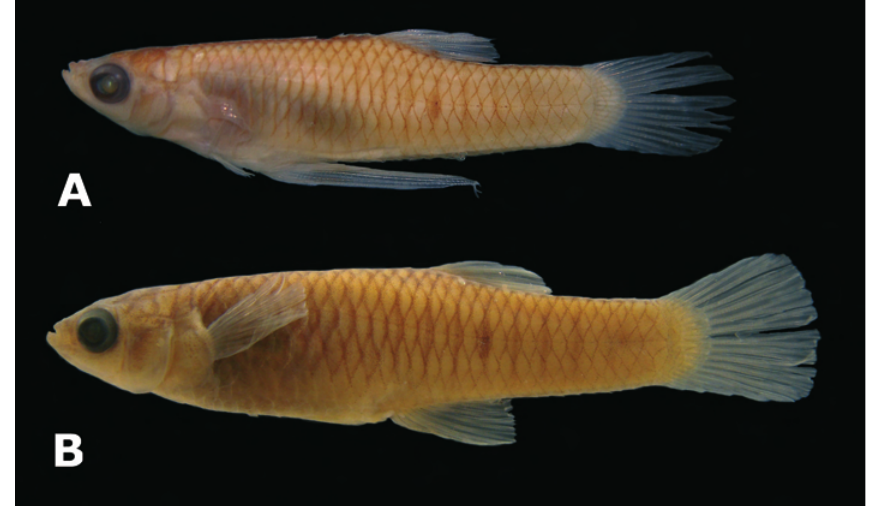
Fig. 50. Phalloceros reisi . (A) Holotype, male, 27.3 mm SL, MCP 30407, creek on Iporanga exit to Apiaí, Apiaí, São Paulo, Brazil; (B) paratype, female, MCP 20579, 34.6 mm SL, collected with the